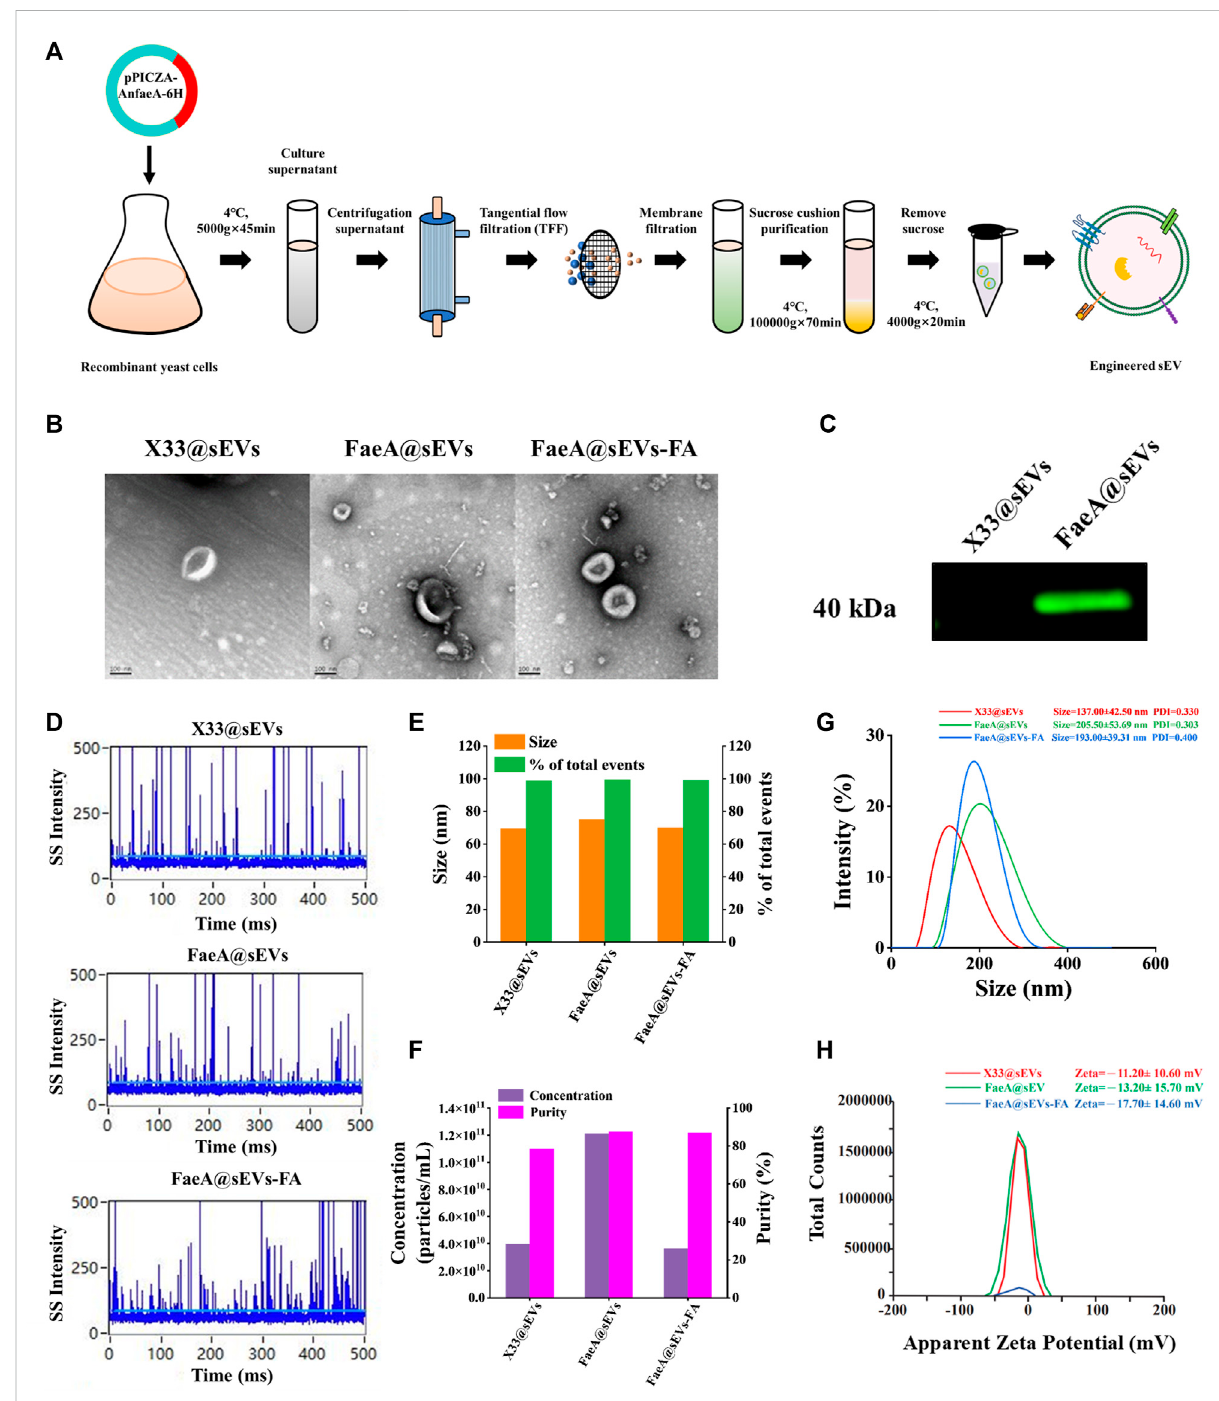
FIGURE 3 Isolation and characterization of sEVs. (A) Schematic protocol of isolation and puri fi cation of sEVs. (B) TEM images of three sEVs, scale bars represent 100 nm. (C) Identi fi cation of FaeA in engineered sEVs by western blotting. (D) Representative SS signal of three sEVs by nano- fl ow cytometry. (E) ParticlesizedistributionandeventpercentageofthreesEVsbynano- fl owcytometry. (F) Particleconcentrationandpurityofthethree sEVs were measured by nano- fl ow cytometry. (G) Particle size distribution and PDI values of three sEVs by Malvern particle size analyzer. (H) Zeta potential distribution of three sEVs by Malvern particle size analyzer. ( n = 3, mean ±